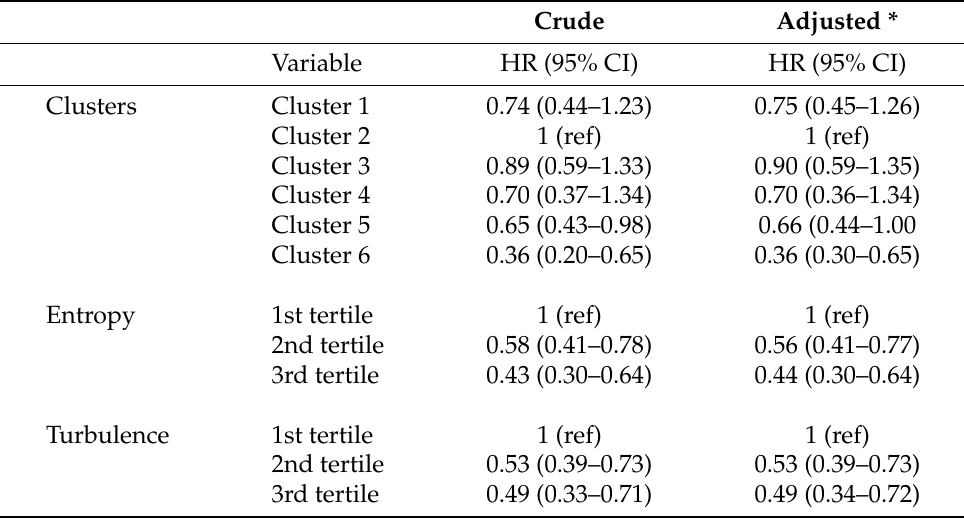
Figure 4. Time to discontinuation of the opioid therapy according to different tertiles of entropy ( A ) and turbulence ( B ). Table 4. Association of clustering and complexity measures with time to discontinuation of opioid therapy. Results from crude and adjusted Cox regression. * Results adjusted by age and